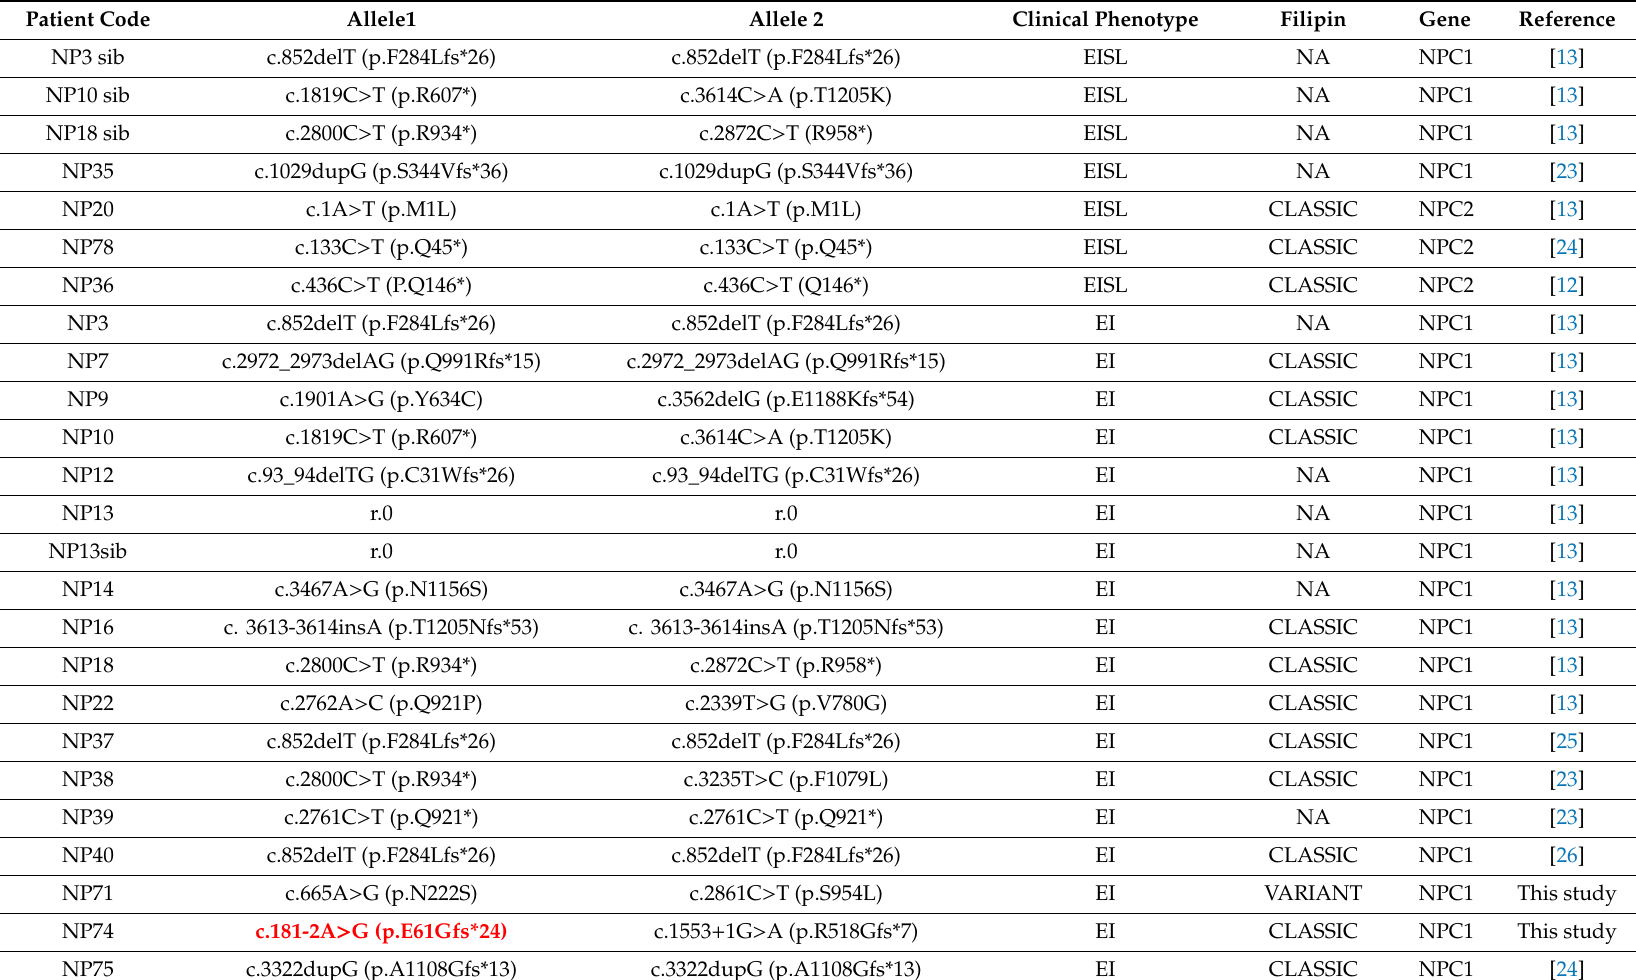
Table 1. Genotype and clinical and biochemical phenotype of Niemann-Pick C patients analyzed in this